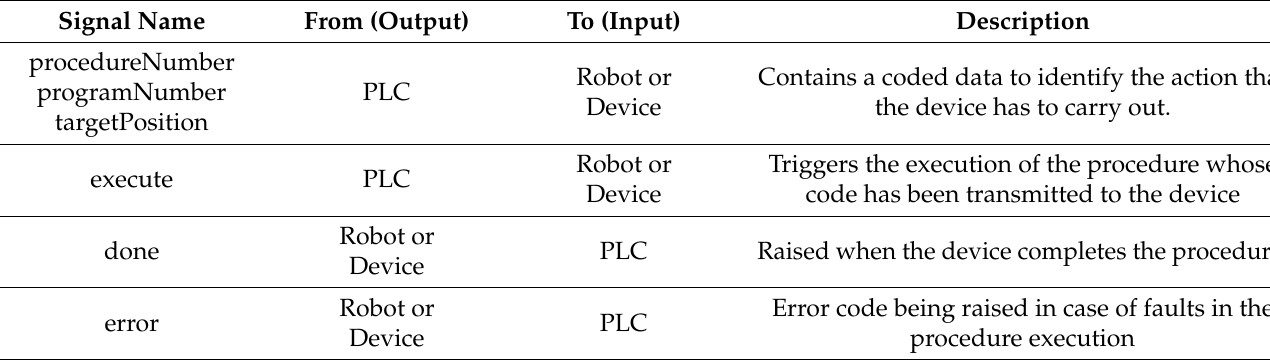
Table 2. List of the core I/O signals exchanged between a robot/device and the